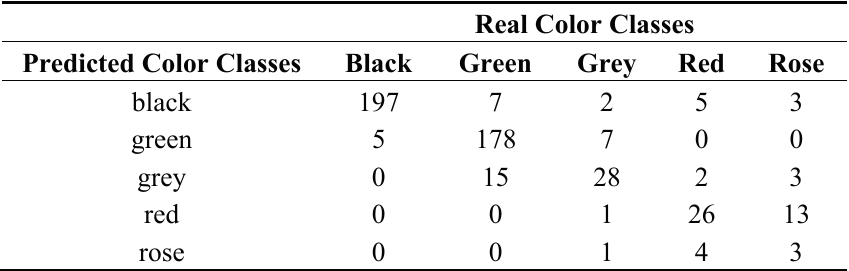
Table 1. Cross-validation of the real berry color classes assessed by visual estimation and the color classes predicted with the